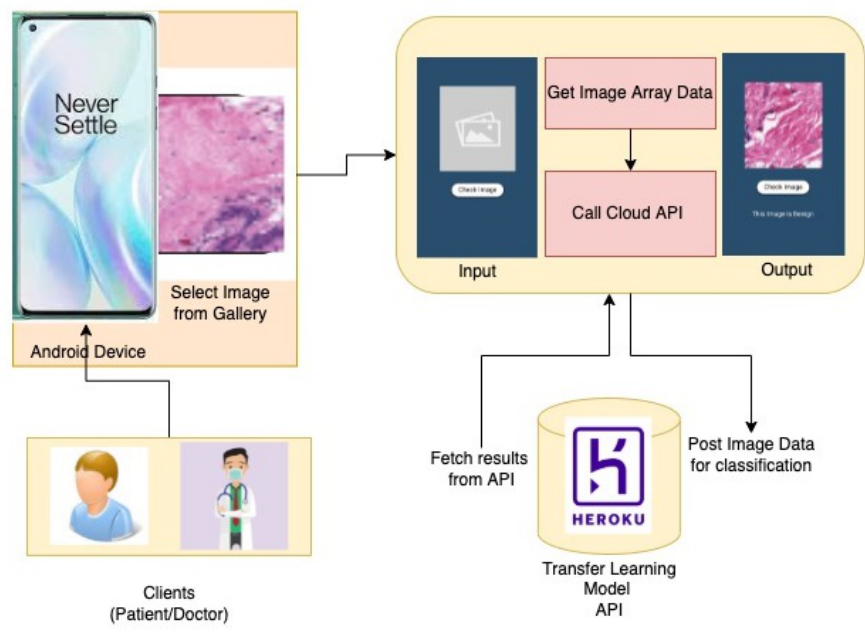
Figure 5. App architecture for